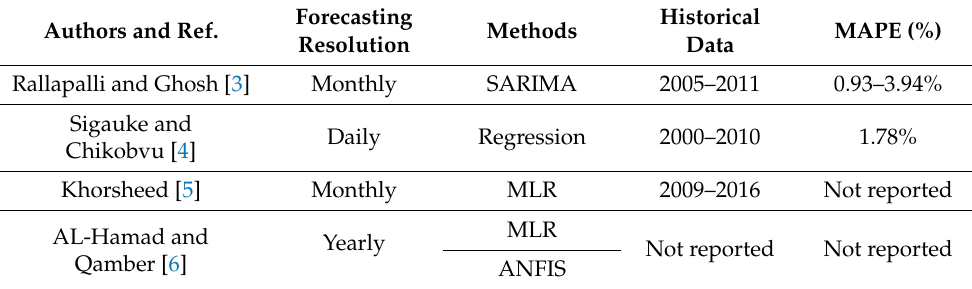
Table 1. Comparison of papers reviewed for peak demand forecasting. Authors and